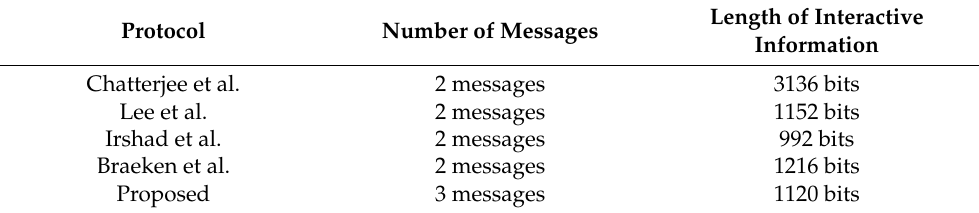
Table 8. Comparison of communication